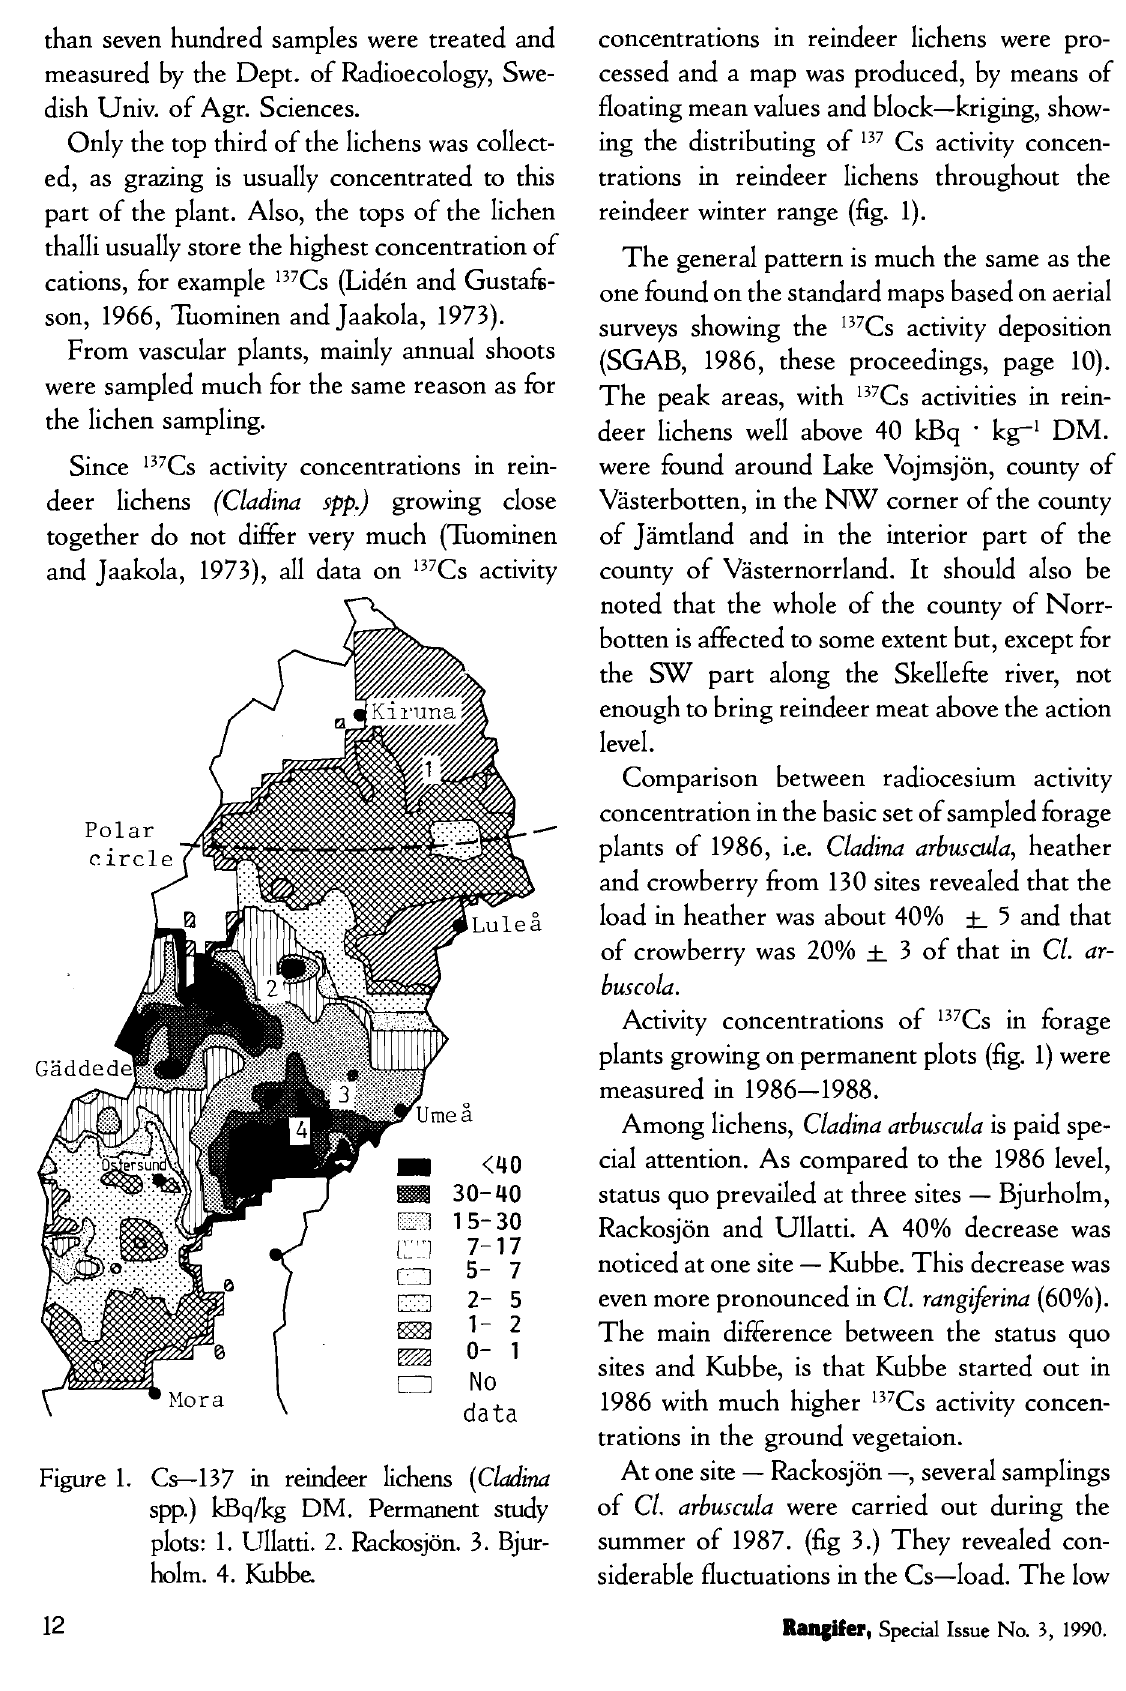
Figure 1. Cs—137 in reindeer lichens (Cladina spp.) kBq/kg D M. Permanent study plots: 1. Ullatti. 2. Rackosjon. 3. Bjur- holm. 4.